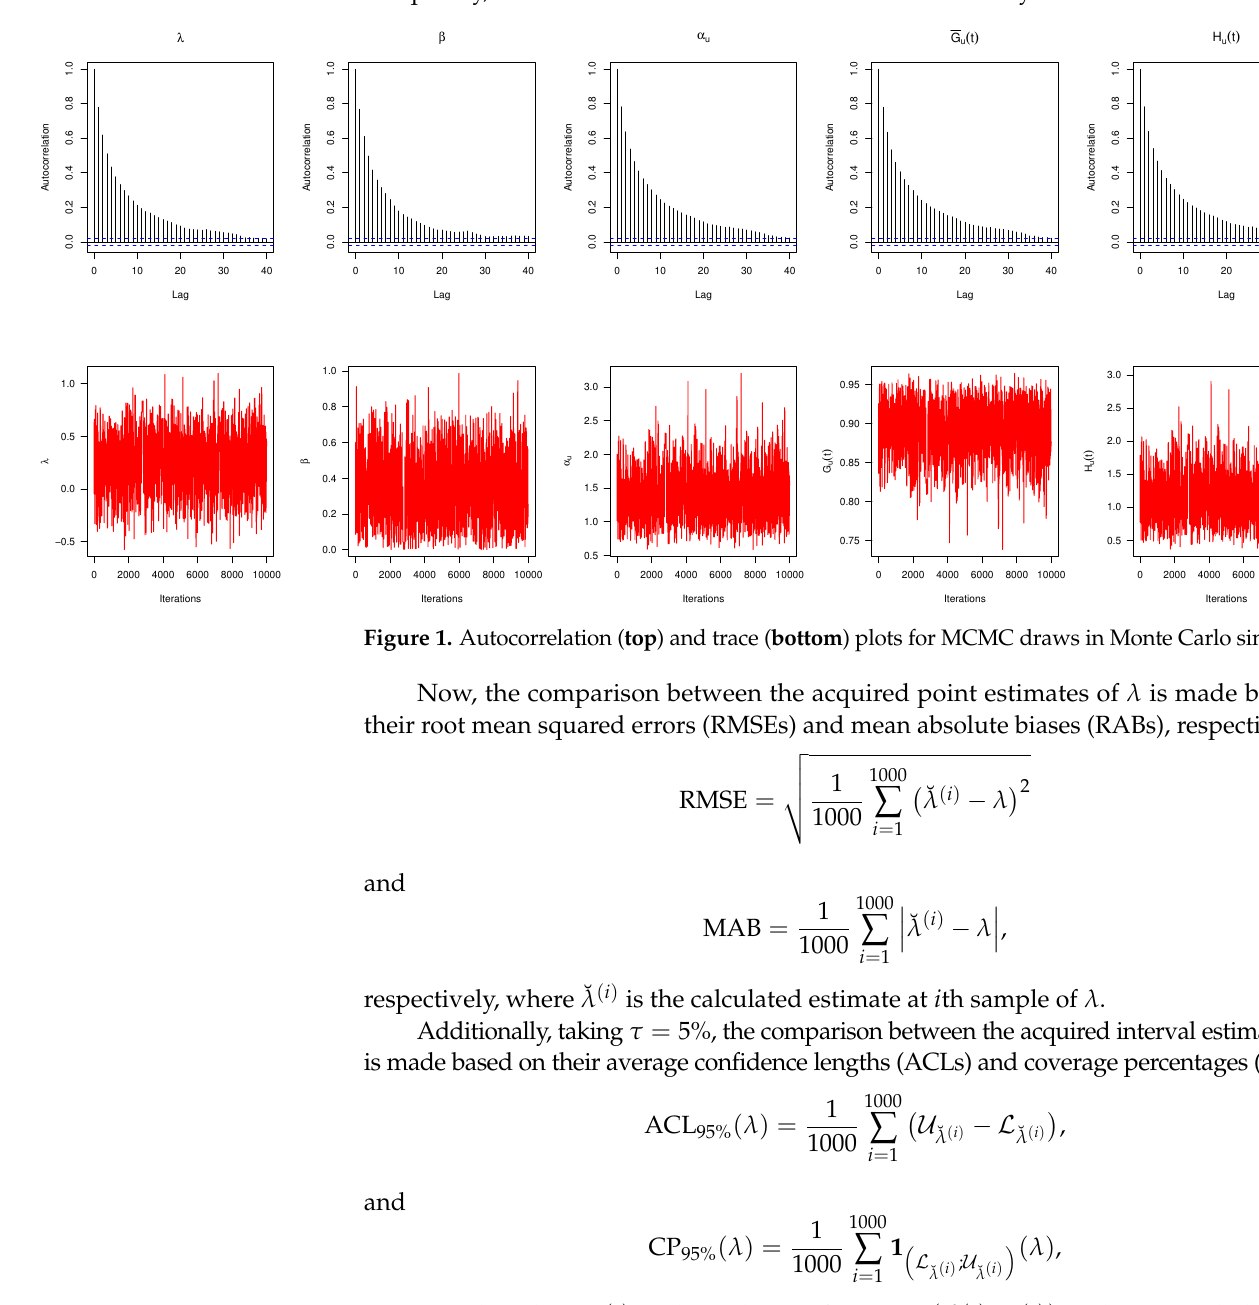
1 (cid:16) (cid:17) ( λ ) , L U ˘ λ ( i ) ; ˘ λ ( i )